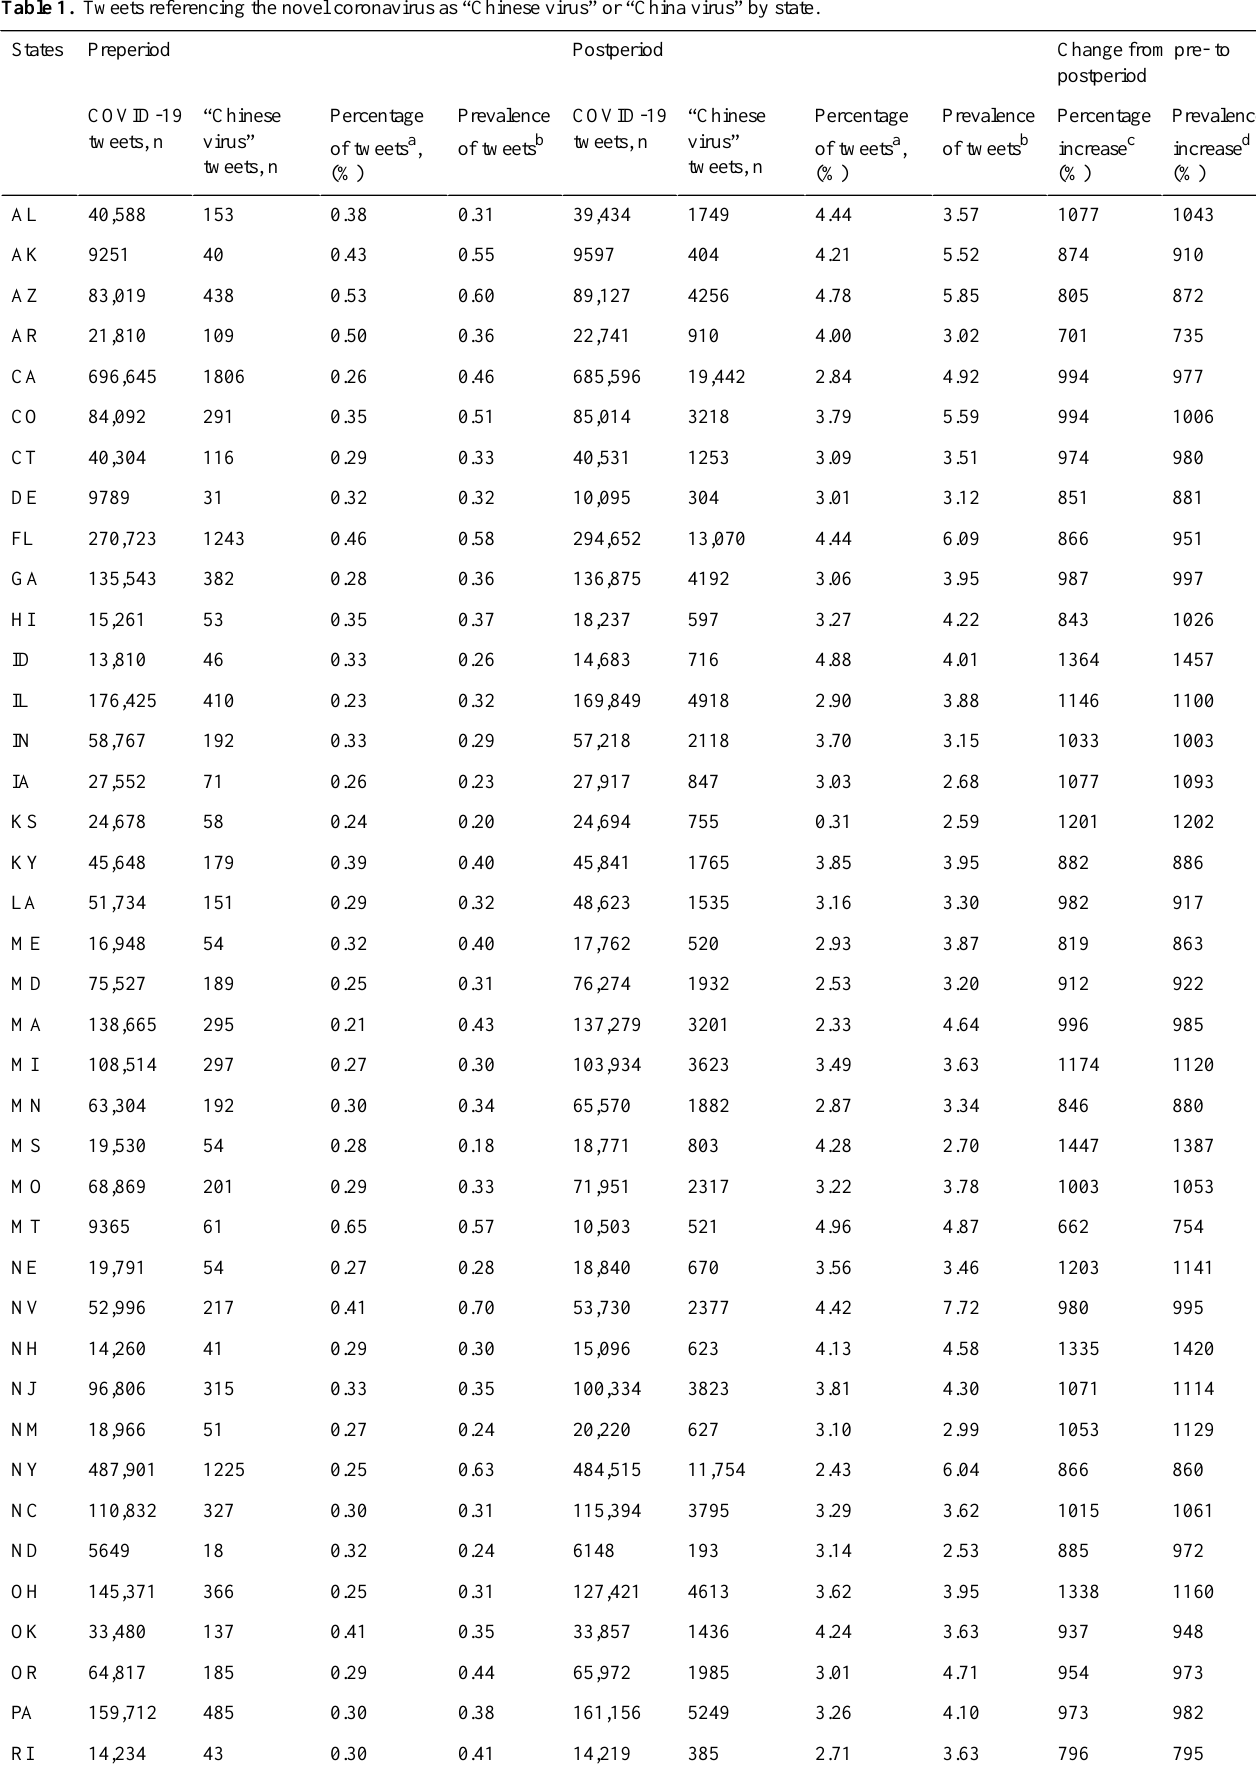
Table 1. Tweets referencing the novel coronavirus as “Chinese virus” or “China virus” by state.